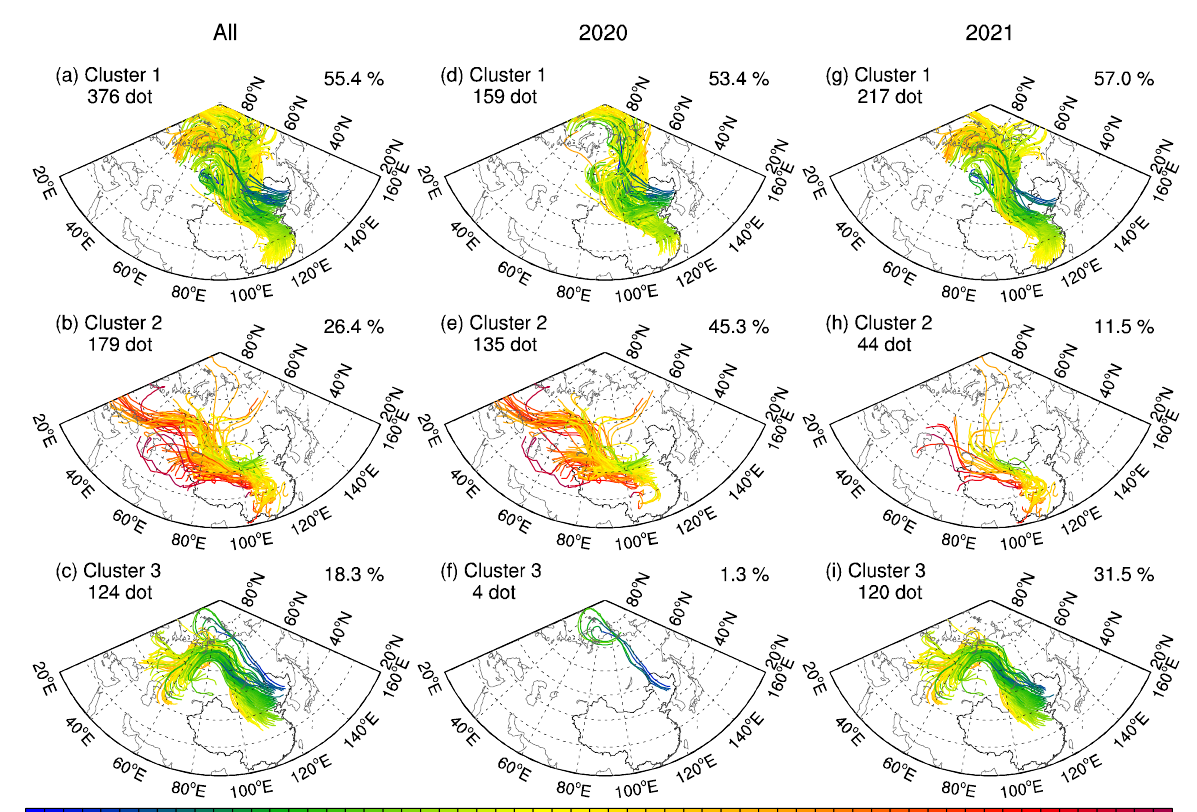
Figure 4. Cold air trajectories (line) and the corresponding potential temperatures (shading, unit: K) during 7 days before the final day of the two events for ( a , d , g ) cluster 1, ( b , e , h ) cluster 2, and ( c , f , i ) cluster 3. Trajectories in ( a – c ) are all the trajectories in two events, while those in ( d – f ) and ( g – i ) are in the 2020 and 2021 events, respectively.